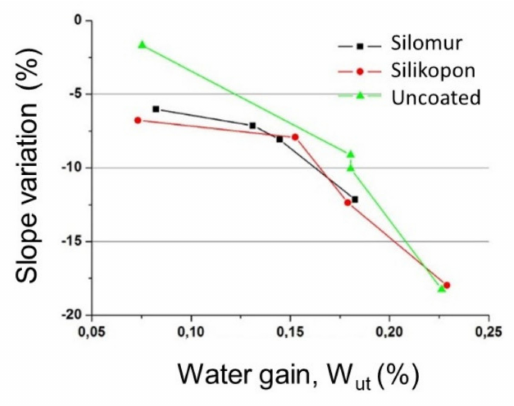
Figure 5. FIMEC slope as a function of water uptake.